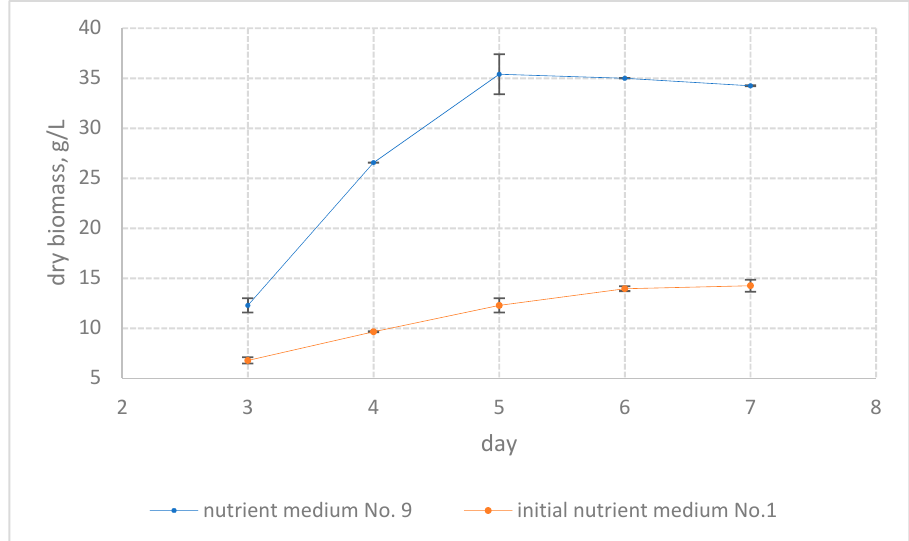
Figure 5. Accumulation of F. velutipes biomass during submerged cultivation on the initial nutrient medium No. 1 and nutrient medium No. 9 of the first steep ascent experiment.